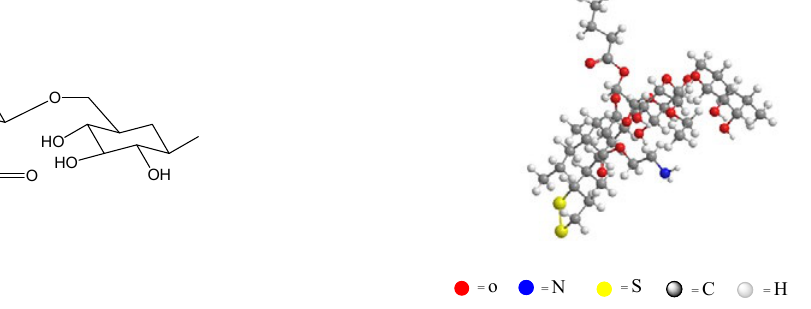
Fig. 2. Pre-polymer structure of lipoic acid-dextran Pre-polymer structure of lipoic acid-dextran